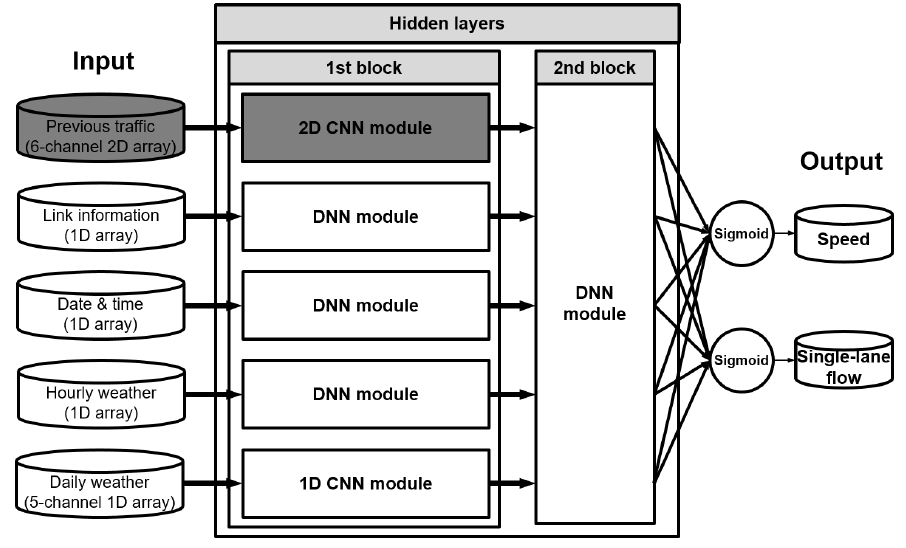
Figure 4. Structure of iterative traffic predictor.